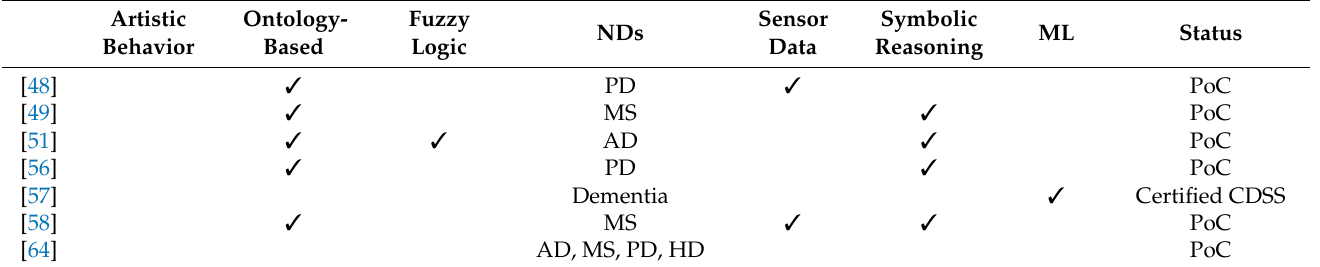
Table 2. Comparative table of reviewed ES/DSS supporting specific